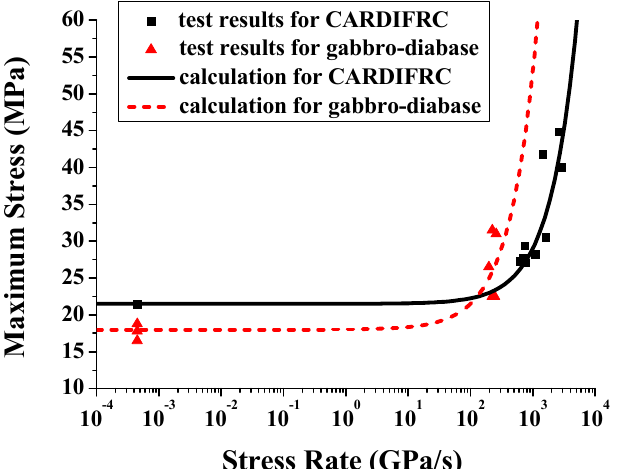
Figure 3: The split tests of CARDIFRC and gabbro-diabase; black squares are the experimental values for CARDIFRC [2]; black line is predictions of Eq. (2) for CARDIFRC ( σ = 23 MPa and τ = 15 μ s); red triangles are the experimental values for gabro-diabase [3]; c = 18 MPa and τ = 70 μ and red dashed is predictions of Eq. (2) for gabbro-diabase ( σ c